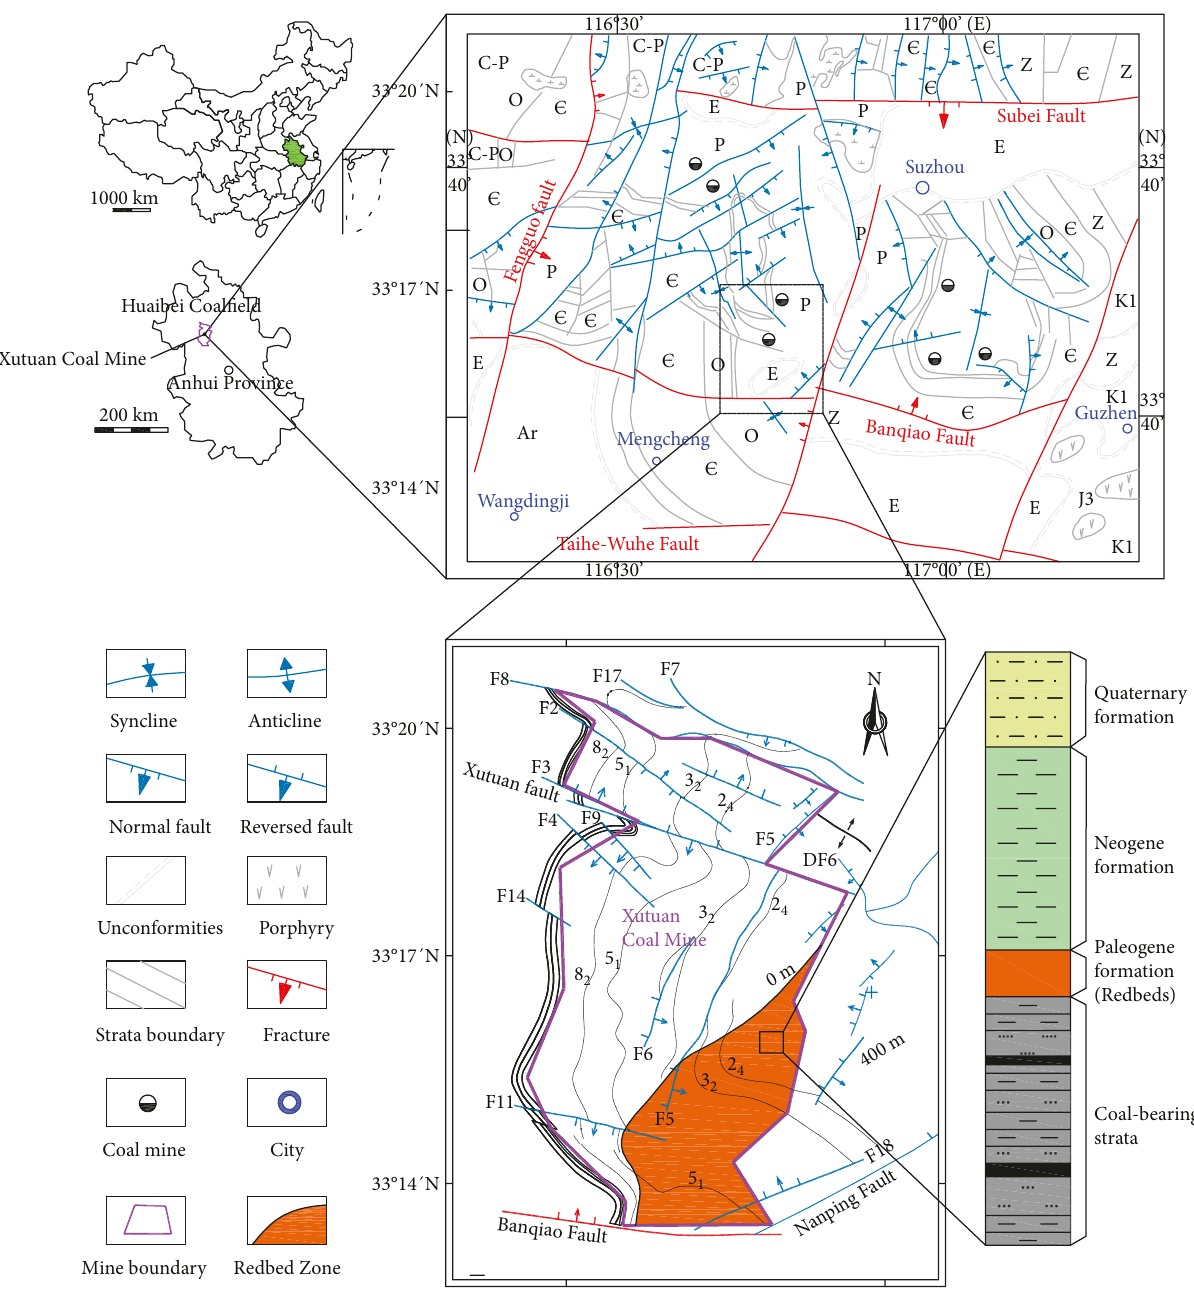
Figure 1: Regional structure of the Lin-Su mining area in Huaibei Coal fi eld and structural outlines of the Xutuan coal